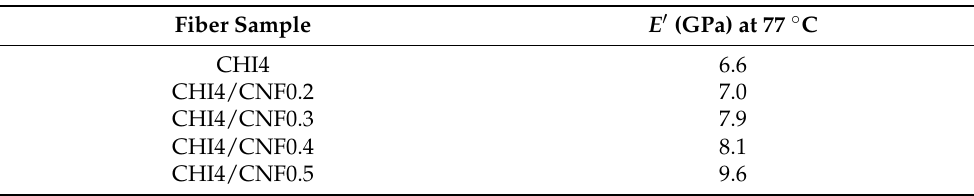
Table 3. Storage modulus E (cid:48) obtained at 77 ◦ C in DMTA measurements (Figure 7) of spun CHI/CNF fibers of varied